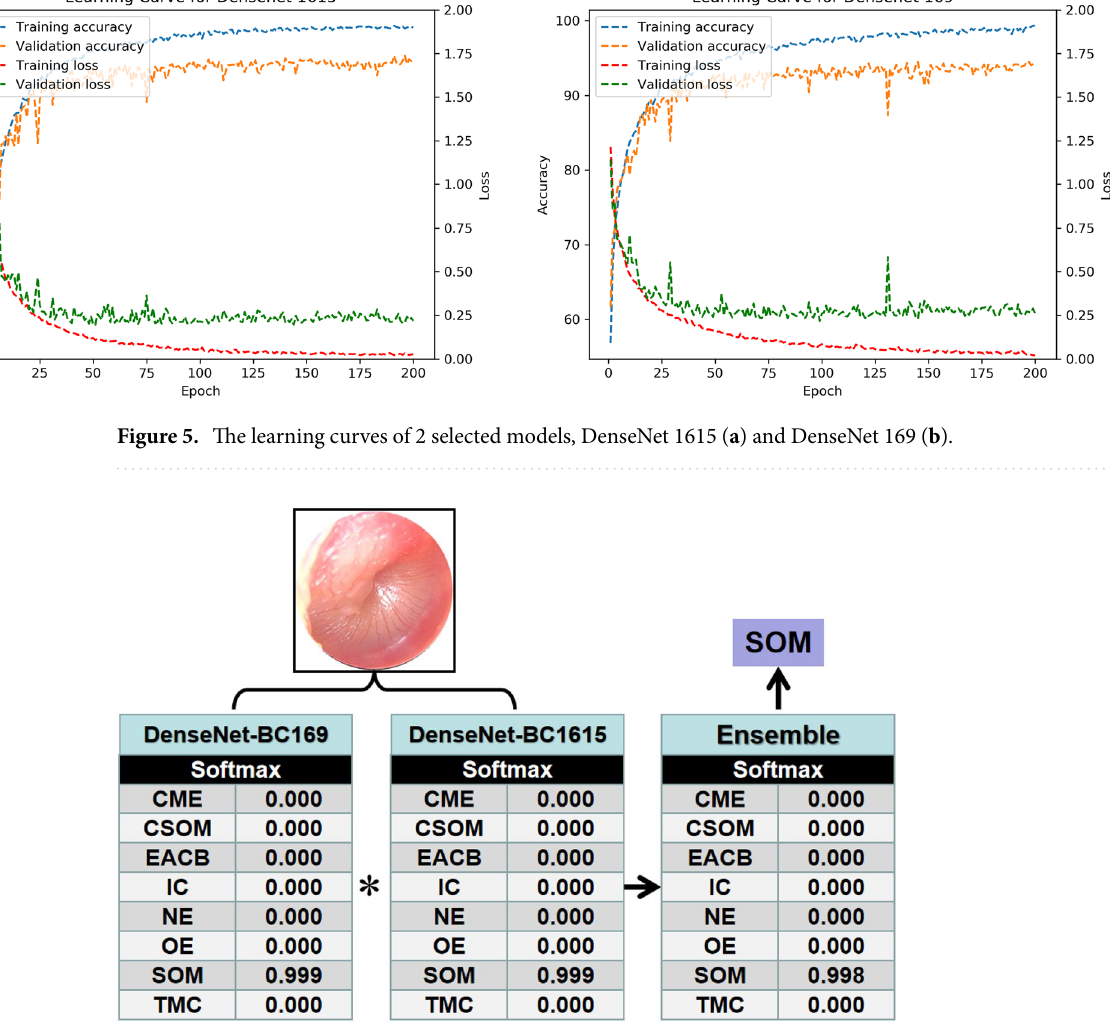
Figure 6. A sketch of structure and an operating diagram for the ensemble method classifies given otoendoscopic